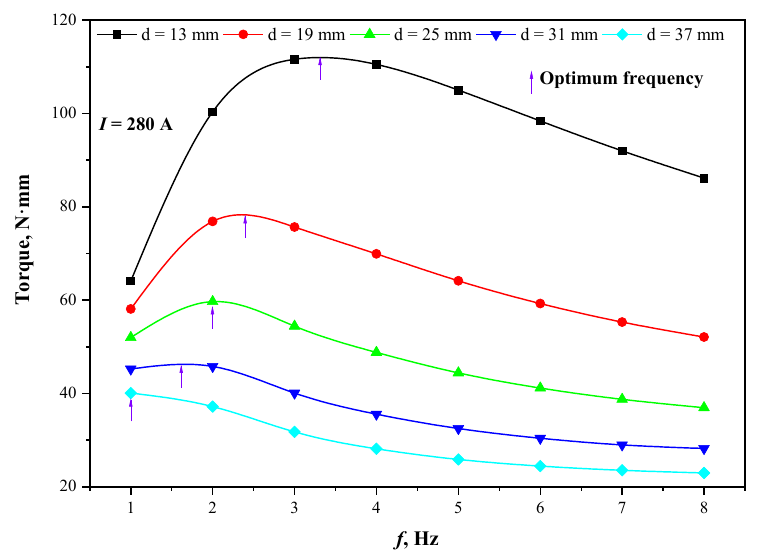
Figure 10. Effect of different thickness of mold copper tube on stirring intensity. When the M-EMS center coincides with the center of the strand, the electromagnetic force distribution on the cross-section of the strand in the center of the stirrer, at the current intensity of 280 A and frequency of 2 Hz, is shown in Figure 11. When the section size is reduced from Φ 650 mm to Φ 550 mm, the thickness of the mold copper tube is reduced by only 2 mm, but the strand surface is farther away from the coil, so that the magnetic field cannot effectively penetrate the 29 mm thick copper tube after decaying in the air, and thus the maximum electromagnetic force rapidly decays from 440.0 N · m − 3 to 227.4 N · m − 3 . As the section size continues to be reduced to Φ 450 mm and Φ 350 mm, the thickness of the copper tube is 25 mm; although the attenuation of the magnetic field in the air is intensified, the copper tube can be also effectively penetrated by the attenuated magnetic field, and the electromagnetic force is greater than that under the section size of Φ 550 mm due to the weakened magnetic shielding effect of the copper tube. Although the thickness of the copper tube for section Φ 450 mm and Φ 350 mm are both 25 mm, when the section size is reduced, the inner diameter of the copper tube is also reduced, resulting in a decrease in volume, which can ultimately increase the electromagnetic force acting on the Φ 350 mm strand. Comprehensive analysis shows that under the action of a magnetic field with a certain frequency, the attenuation of the magnetic field in the air that can effectively pass through the copper tube with a certain thickness should be minimized, and thus M-EMS with a section size of Φ 650 mm has the highest efficiency in converting electromagnetic energy into kinetic energy. In the actual production of round blooms in the plant, M-EMS needs to adapt to four types of the strand with section sizes of: Φ 650 mm, Φ 550 mm, Φ 450 mm, and Φ 350 mm. The thicknesses of the copper tube for each section are: 31 mm, 29 mm, 25 mm, and 25 mm, respectively. The horizontal installation position of the M-EMS designed according to the maximum section Φ 650 mm is fixed with the outer arc as the reference line, which results in a large deviation between the central axis of the strand with a smaller diameter and the central axis of the M-EMS as shown in Figure